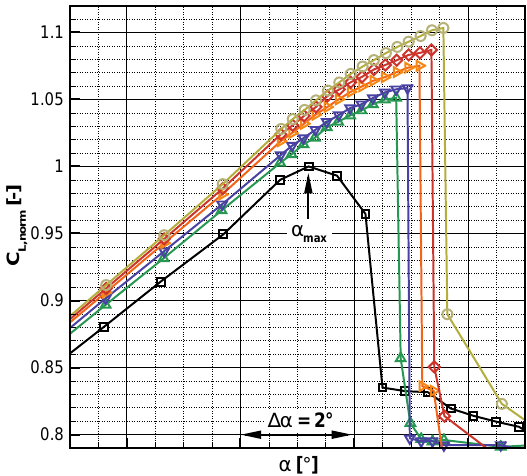
Figure 15. Lift coefficient for forcing with Segments 1 and 3 for various c µ ; see Figure 14 for the line